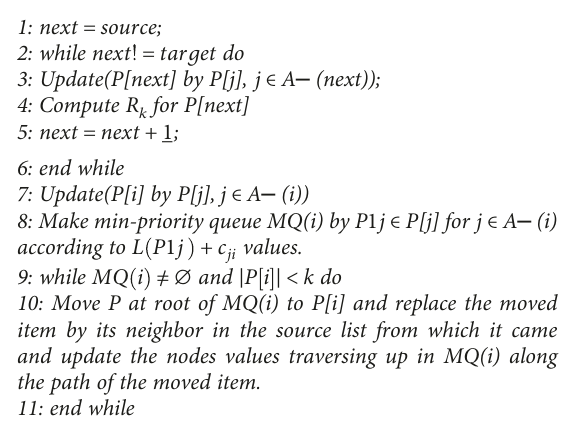
Figure 3: Modi fi ed T ∗ algorithm fl ow chart for metabolic network reconstruction. Table 2: Computed cost of predicted